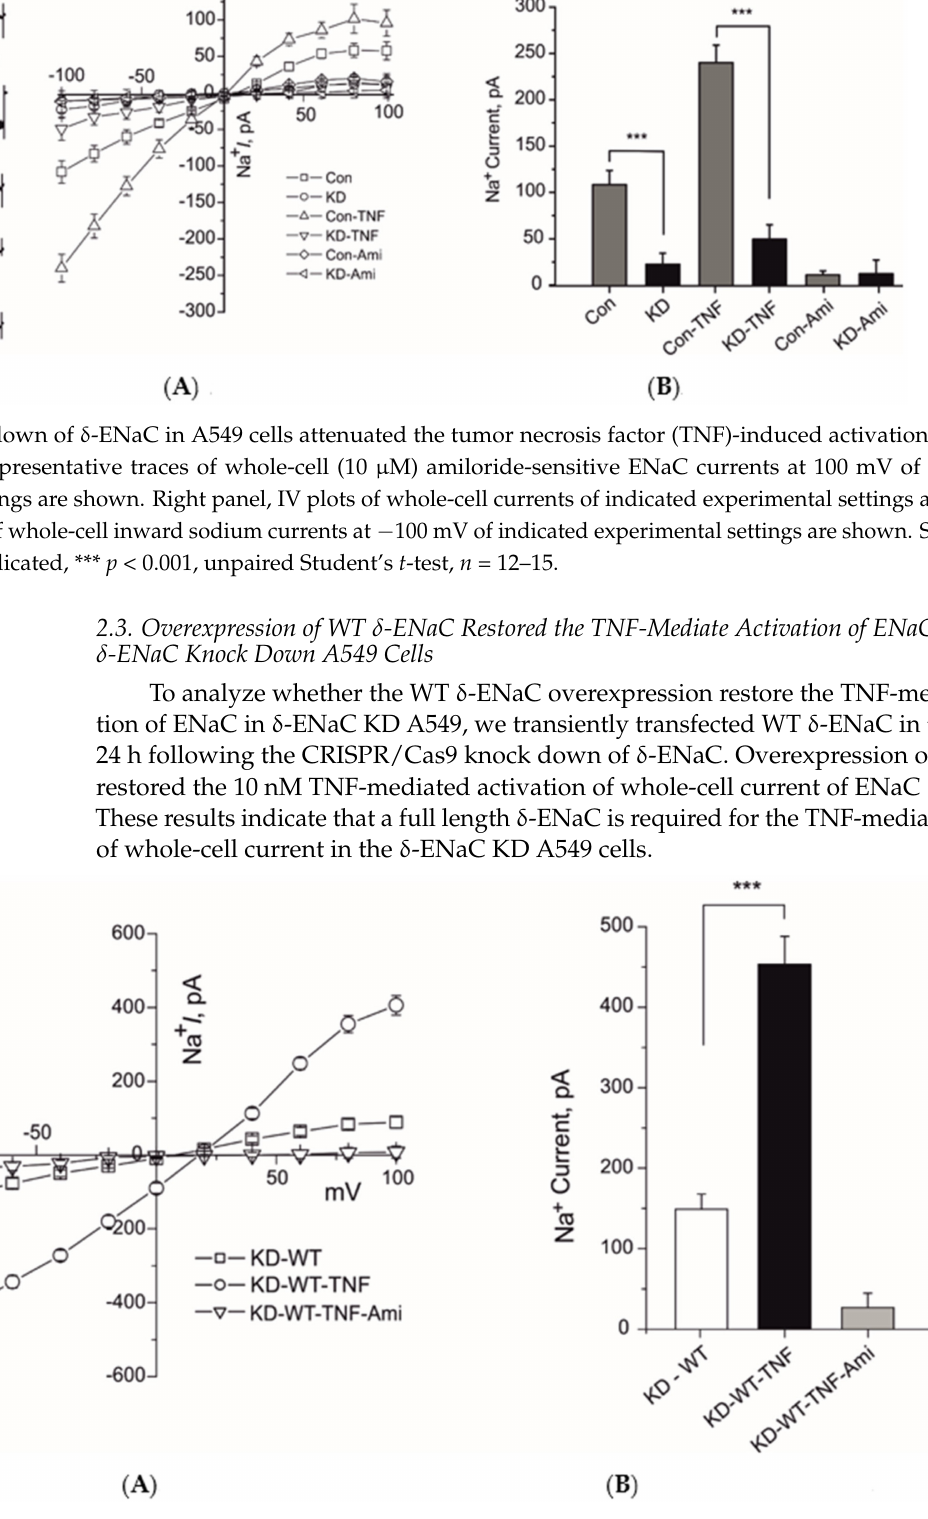
Figure 3. Overexpression of δ wild-type (WT) restored the TNF mediated activation of ENaC in δ -ENaC KD A549 cells. ( A ) left panel, IV plots of whole-cell (10 µ M) amiloride-sensitive ENaC currents of indicated experimental settings are shown. ( B ) Mean values of whole-cell inward sodium currents at − 100 mV of indicated experimental settings are shown. Significant differences are indicated, *** p < 0.001, unpaired Student’s t -test, n =